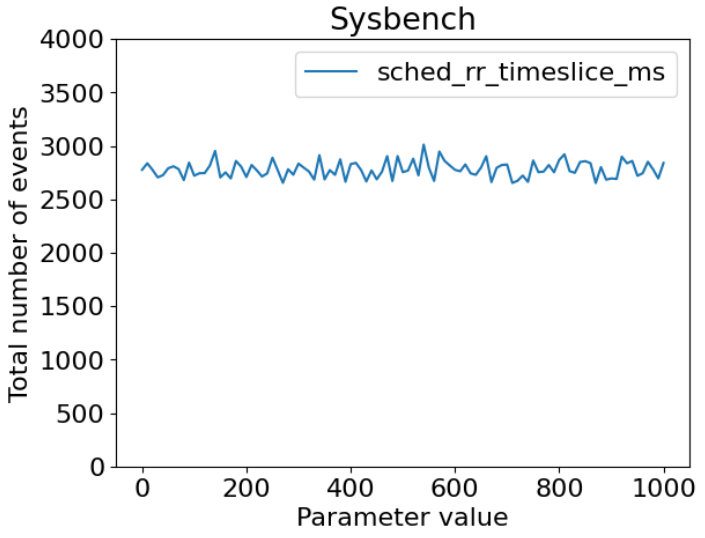
Figure 3. Performance change according to the increase in sched_rr_timeslice_ms based on the FIFO